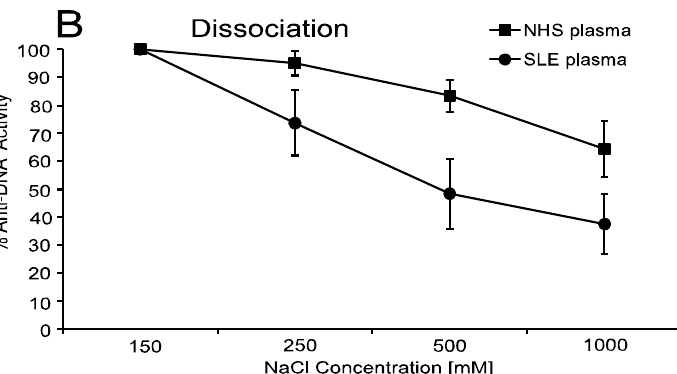
Figure 2. The effects of ionic strength on anti-DNA interactions with MC DNA. The figure illustrates the effects of increasing ionic strength on the binding of NHS anti-DNA and SLE anti-DNA to MC DNA in association (Panel ( A )) and dissociation (Panel ( B )) assays. As the data indicate, the binding of NHS anti-DNA was less sensitive to the effects of ionic strength than SLE anti-DNA, suggesting differences in the role of electrostatic interactions in binding. The study involved five SLE sera and four NHS sera. Means and standard deviations are shown.